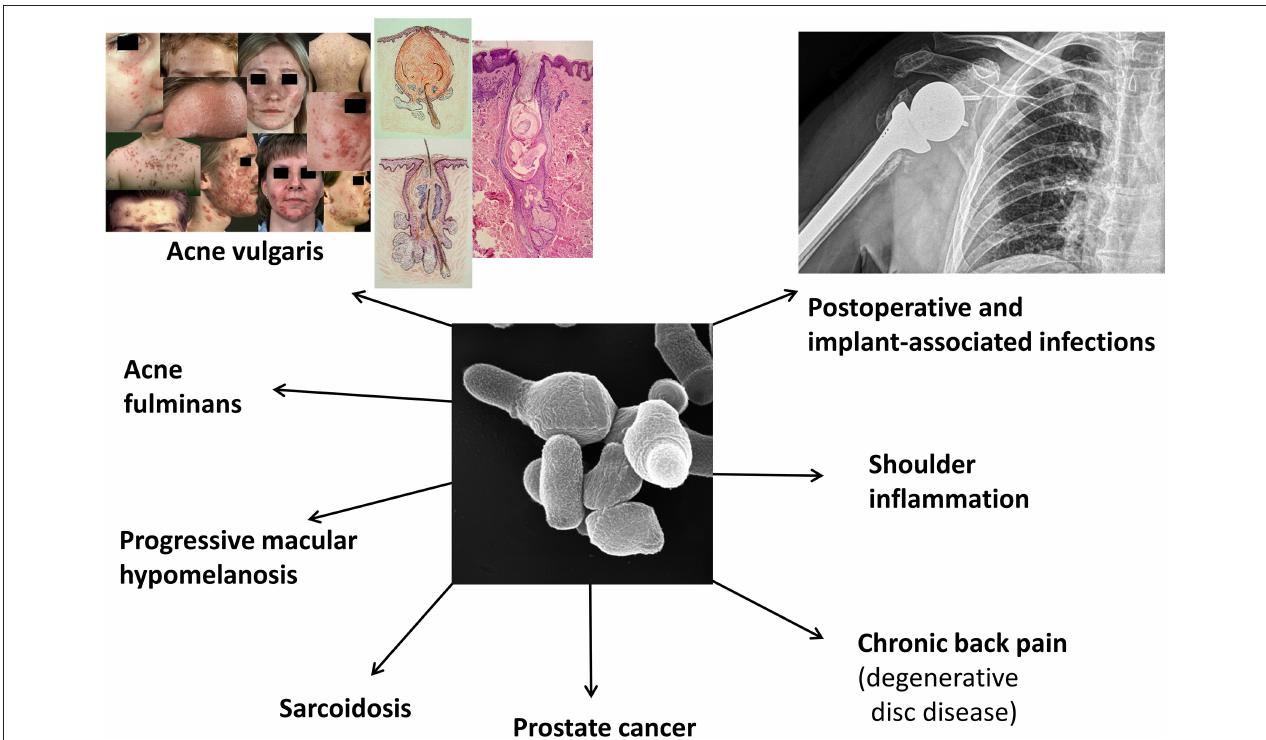
FIGURE 1 | Known or suspected disease associations of C. acnes . Shown are currently investigated and debated disease associations of C. acnes. In this review we mainly focus on acne vulgaris, implant-associated infections, and a few native infections. The clinical pictures regarding acne vulgaris are taken from Gollnick and Zouboulis (2014)